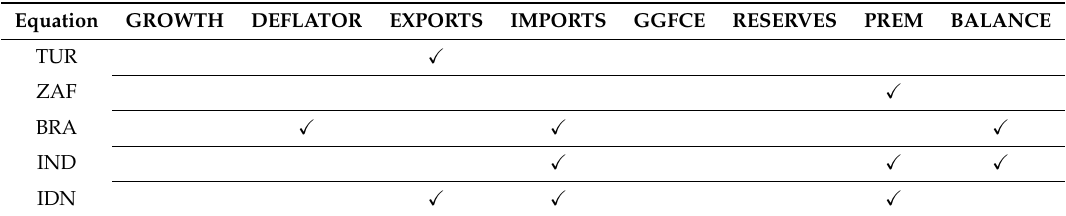
Table 10. Important variables per